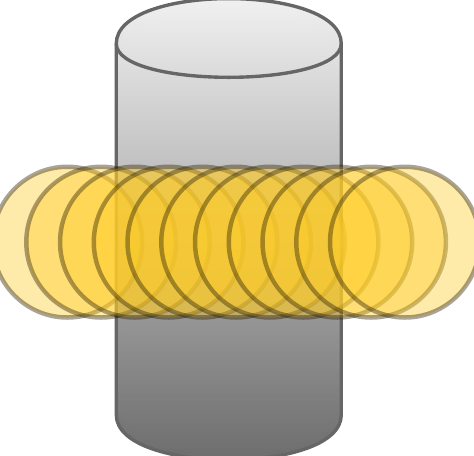
Figure 7. Stem at 10 m. Diameter 20 cm; the angle separation between beam centers of 0.17 degrees gives a 2.9-cm separation on the stem; beam divergence 0.68 degrees + spot size 1.4 cm equals a 13.3-cm footprint.